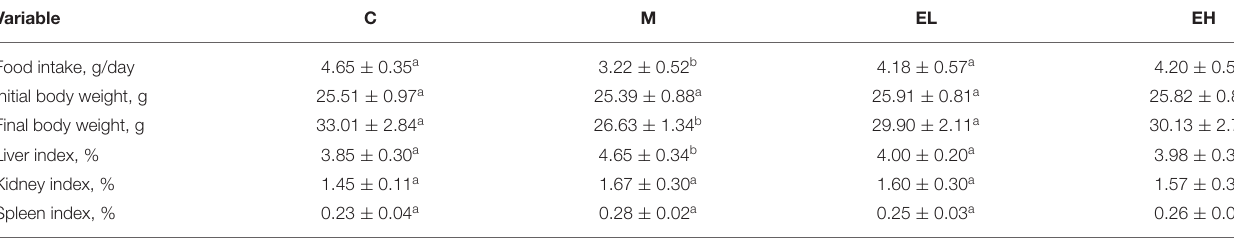
TABLE 2 | Effect of ellagic acid on food intake, body weight, and organ index in mice.